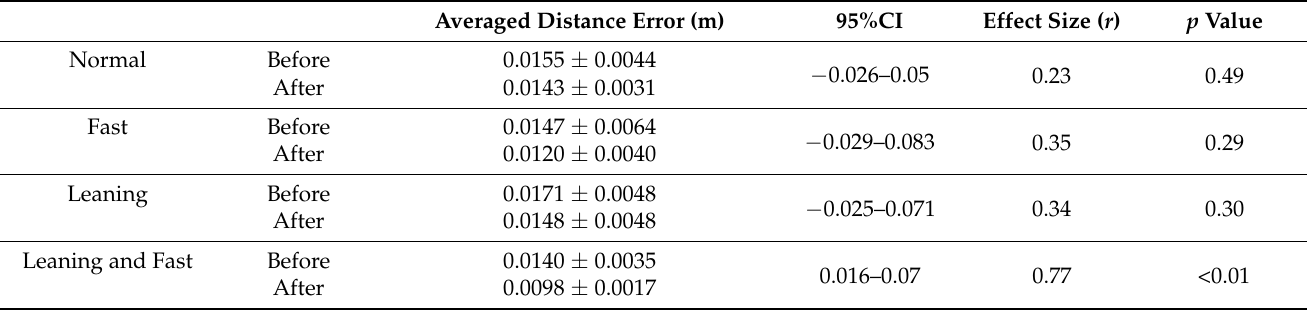
Table 2. Average distance error in the STG for heel anterior obstacle crossing. Averaged Distance Error (m)